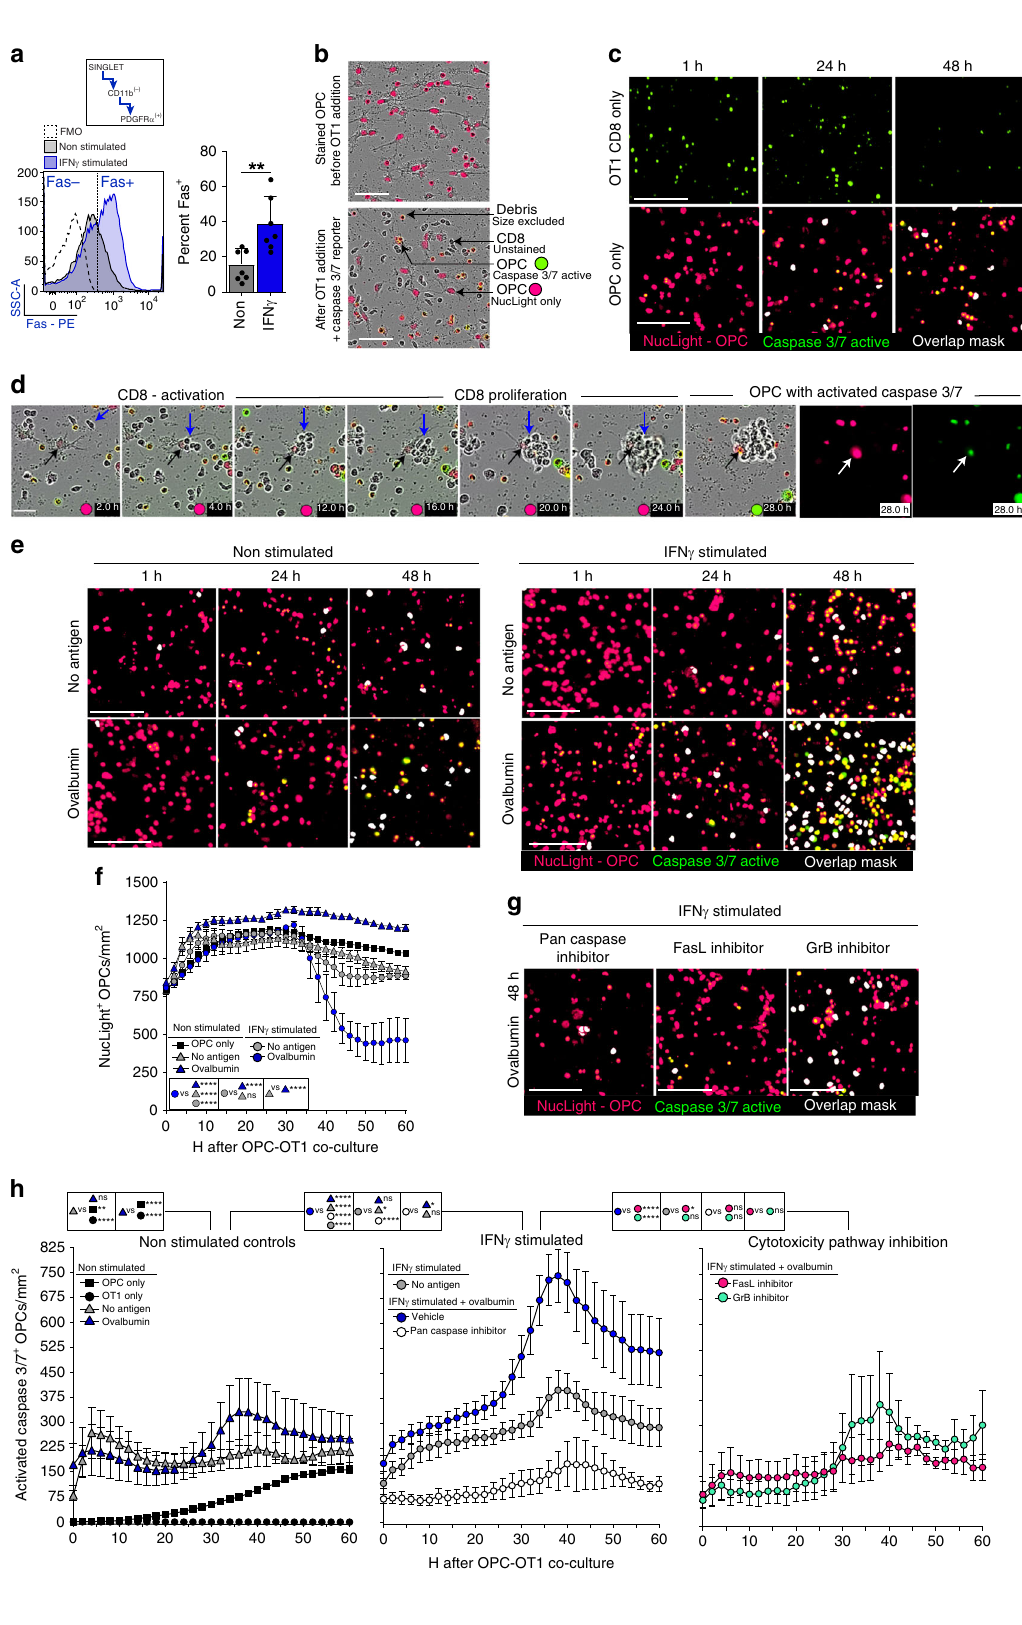
Methods 2D2 MOG 35 – 55 TCR transgenic mice (C57BL/6-Tg(Tcra2D2,Tcrb2D2)1Kuch/J) Mice . Mice were housed and maintained in a pathogen-free animal facility at Johns and were originally purchased from Jackson Laboratory and maintained in-house. C3HeB/Fej (000658) were purchased from Jackson Laboratory as needed for Hopkins University. TRE/IFN γ and GFAP/tTA mice were a kindly provided by B. experimentation. C57BL/6 (556) and SAS SD timed-pregnant rats were purchased Popko (University of Chicago) and were then crossed and maintained in-house. from Charles River (SD400) for the purpose of postnatal OPC and glia cultures. OVA 257 – 264 TCR transgenic, OT-1 mice (C57BL/6-Tg(TcraTcrb)1100Mjb/J), and NATURE COMMUNICATIONS| (2019) 10:3887